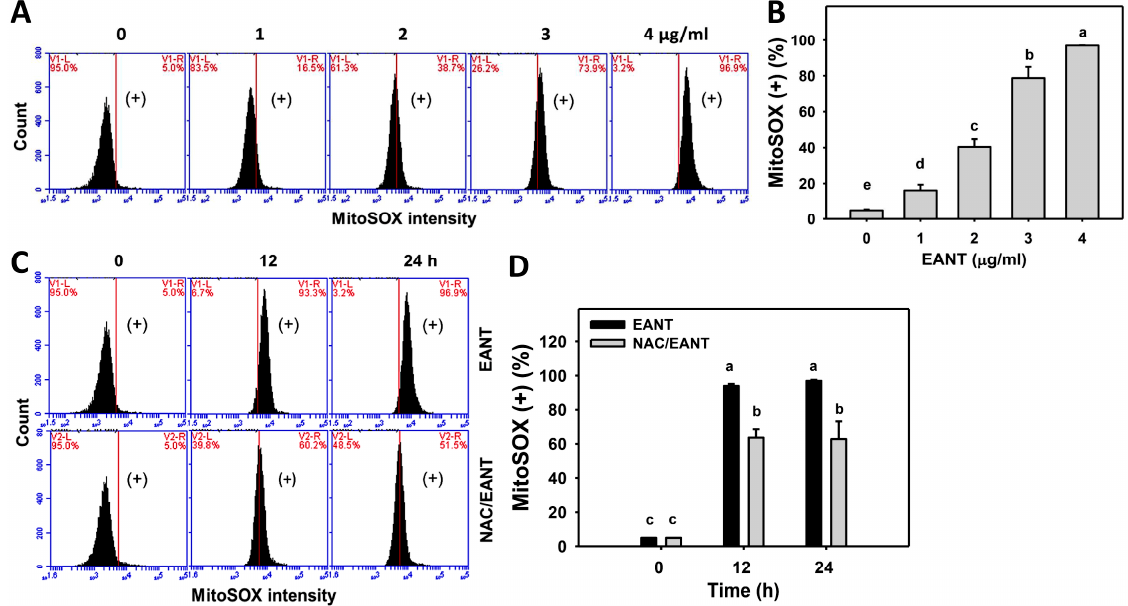
Figure 6. MitoSOX content of EANT-treated leukemia cells. ( A and B ) Histogram and statistical analysis for MitoSOX content. (+) in the right side of each panel is regarded as the population of MitoSOX (+) (%). HL-60 cells were treated with EANT (24 h, 0 to 4 μ g/mL). The control contained 0 μ g/mL EANT but 0.1% DMSO. ( C and D ) Histogram and statistical analysis for MitoSOX content of HL-60 cells following NAC/EANT treatment. NAC/EANT indicates that cells are either pretreated with NAC (5 mM, 1 h) or post-treated with EANT (0 and 4 μ g/mL for 0, 12, and 24 h). Data, mean ± SD ( n = 3). Data showing different letters on the top reveal a significant difference ( p < 0.05–0.0001 for multiple comparisons).